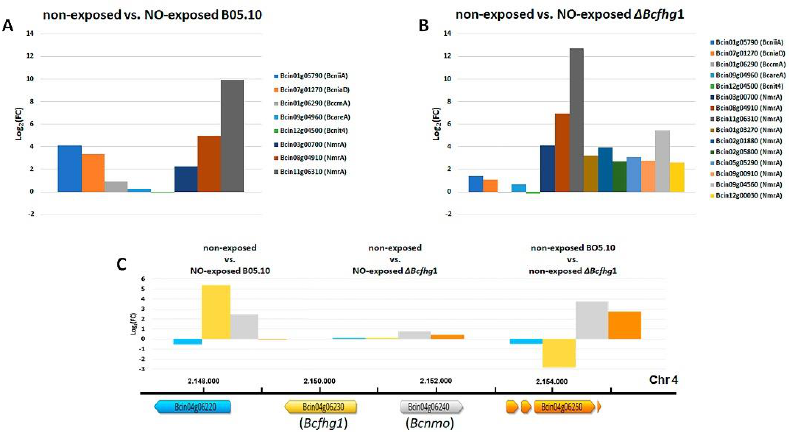
Figure 8. Changes in the expression levels of genes related to nitrate assimilation and of NmrA-like domain-containing protein encoding genes in the comparison of non-exposed and NO-exposed B05.10 ( A ) and non-exposed and NO-exposed Δ Bcfhg 1 ( B ). ( C ) Change in the expression levels of the genes Bcin04g06220, Bcin04g06230 ( Bcfhg 1), Bcin04g06240 ( Bcnmo ) and Bcin04g06250 in the comparison of non-exposed and NO-exposed B05.10, non-exposed and NO-exposed Δ Bcfhg 1 and non-exposed BO5.10 and non-exposed Δ Bcfhg 1. Below the histograms, a representation of the loci they occupy is shown.